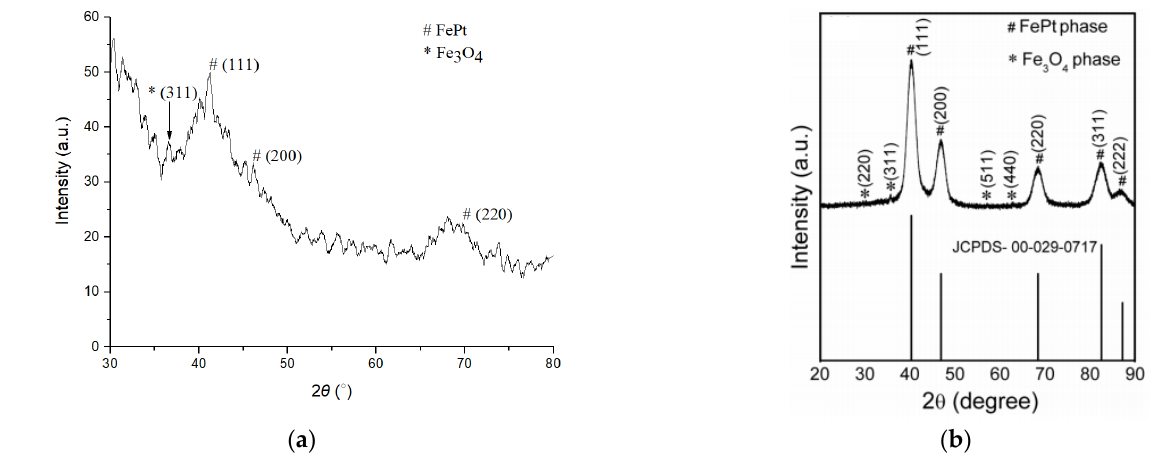
Figure 6. The X-ray diffraction (XRD) patterns of ( a ) the FePt NPs and ( b ) the JCPDS #-29-0717 (fcc-FePt).